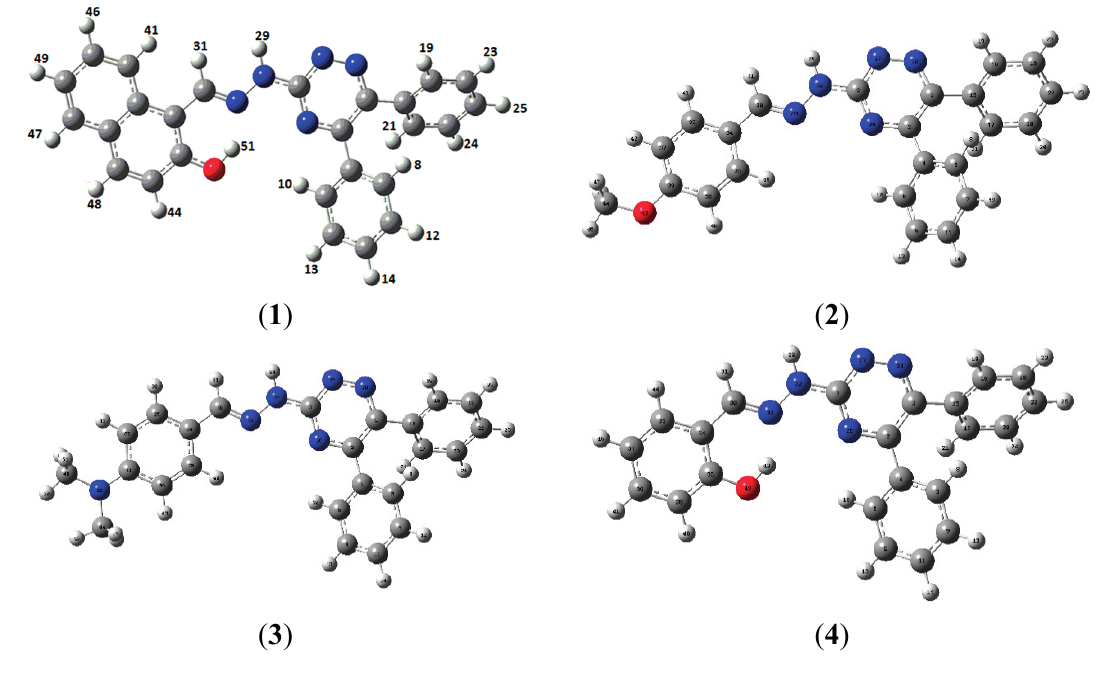
Figure 4. Optimized geometries of compounds ( 1 – 4 ) at B3LYP/6-31G (d, p) level of DFT. Table 3. Selected molecular structure parameters of compound 1